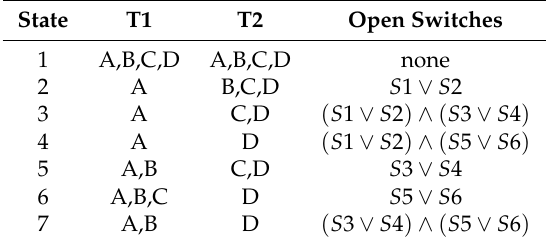
Table 2. Supply states defined by the supply situation in the example grid.